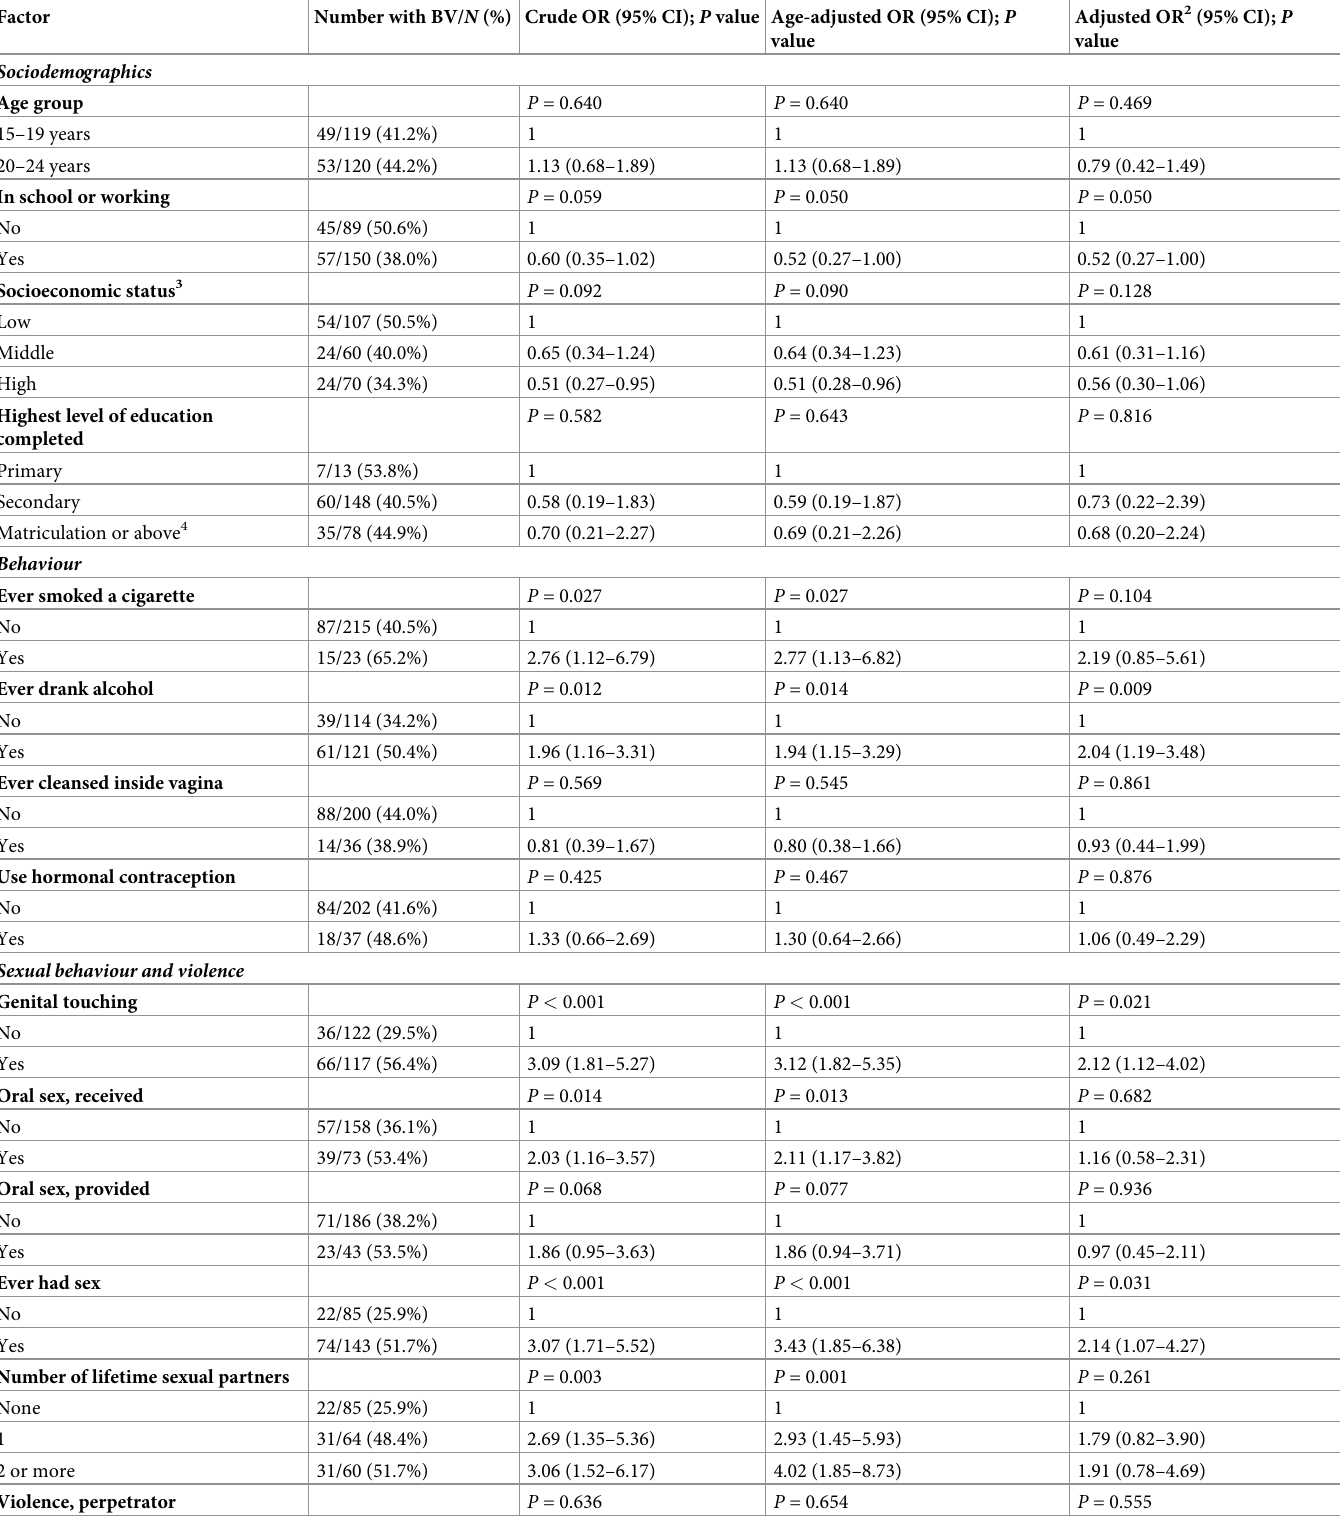
Table 5. Factors associated with BV in young women in a population-based STI survey among young people aged 15–24 years in rural Kwa-Zulu Natal ( N = 239 1